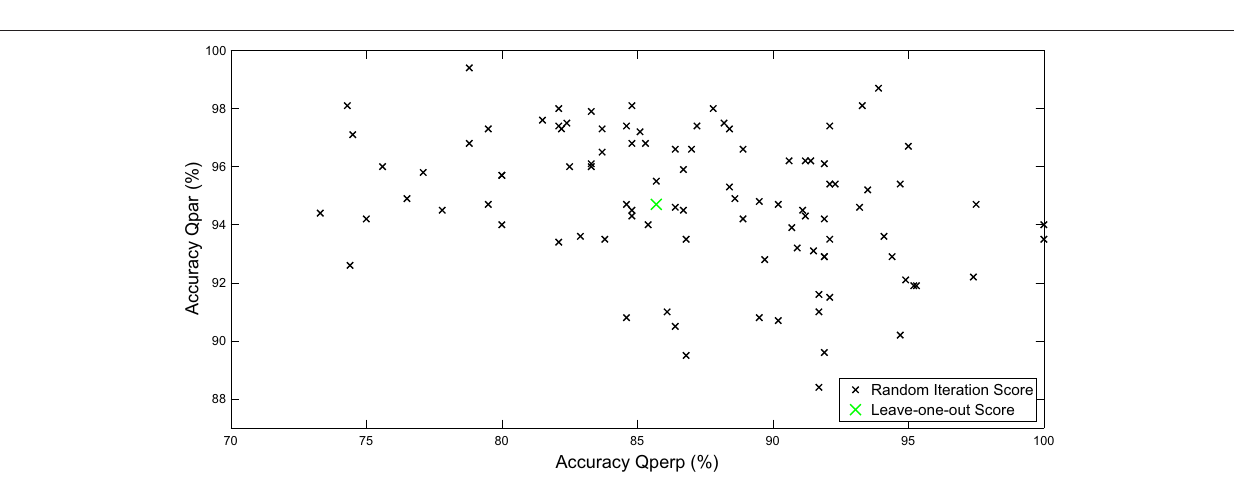
FIGURE 7 | Accuracy of the neural network for 100 different iterations. Left : Results of the quasi-parallel class. Right : Results of the quasi-perpendicular class. The training of the shown neural networks does not includes the IMF vector.